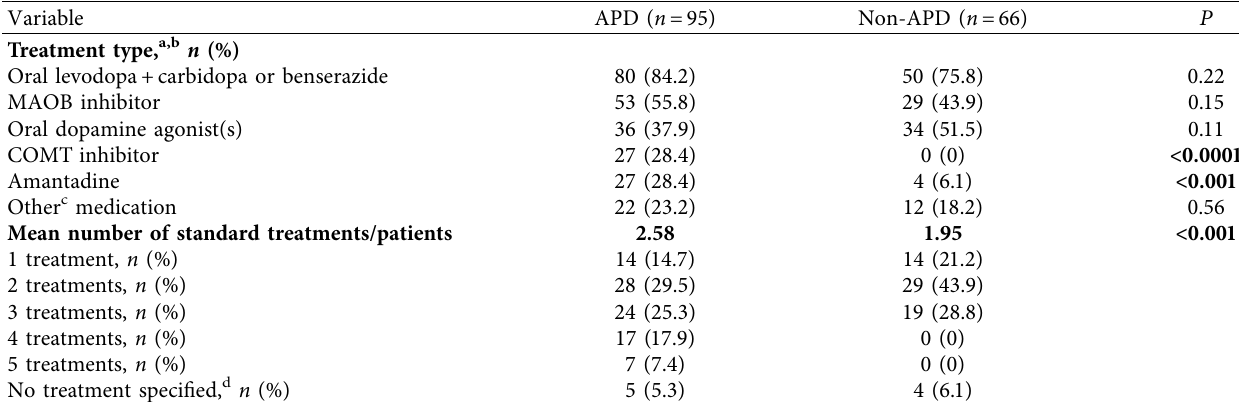
Table 4: Actual conventional treatments. APD versus non-APD.